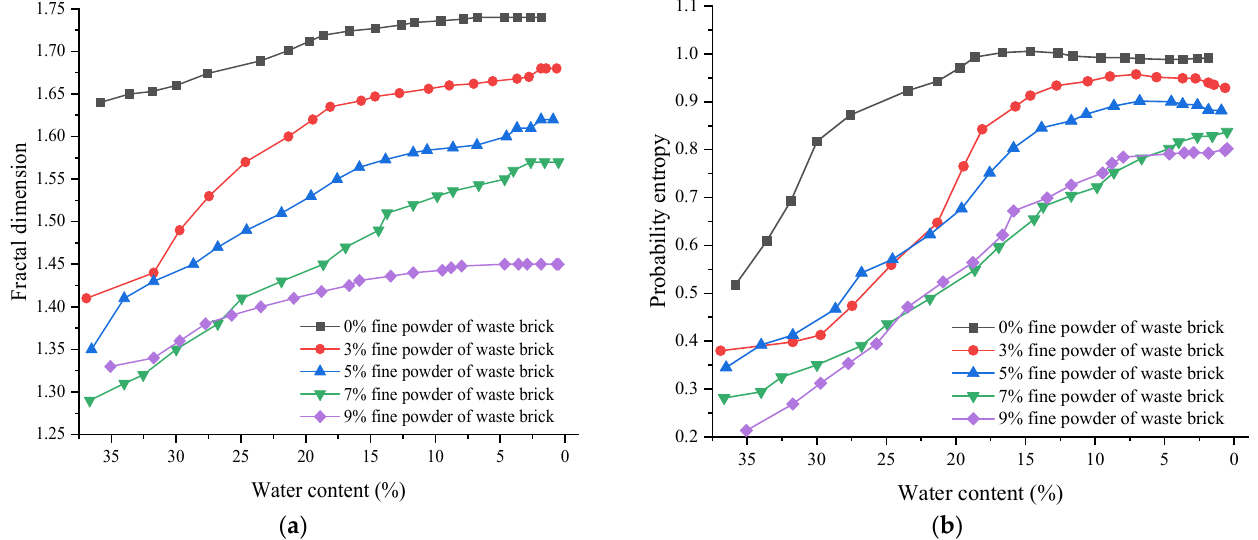
Figure 6. Fractal dimension and probability entropy image changing with water content. ( a ) Fractal dimension changing with water content. ( b ) Probability entropy changing with water content.